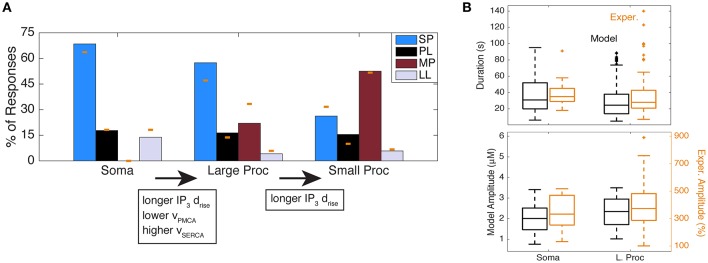
Simulation of response type distributions matching experimental distributions of astrocyte subcompartments. (A) Response type distributions in the model with parameters adjusted to the soma, large processes, and small processes. The yellow bars indicate the experimental data from Figure 2D. (B) Ca2+ durations and amplitudes of all response types in the model (from (A); in black) and experiments (from Figure 2D; in yellow) in the soma and large processes. One outlier was excluded from the experimental soma duration plot, with a duration of 363 s (same outlier omitted from Figure 4B).